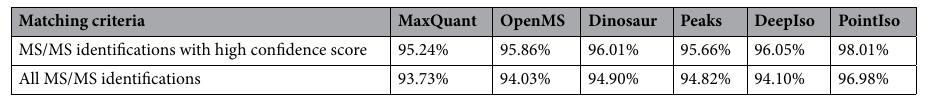
Table 1. Percentage of MS/MS identifications matched by feature list produced by different